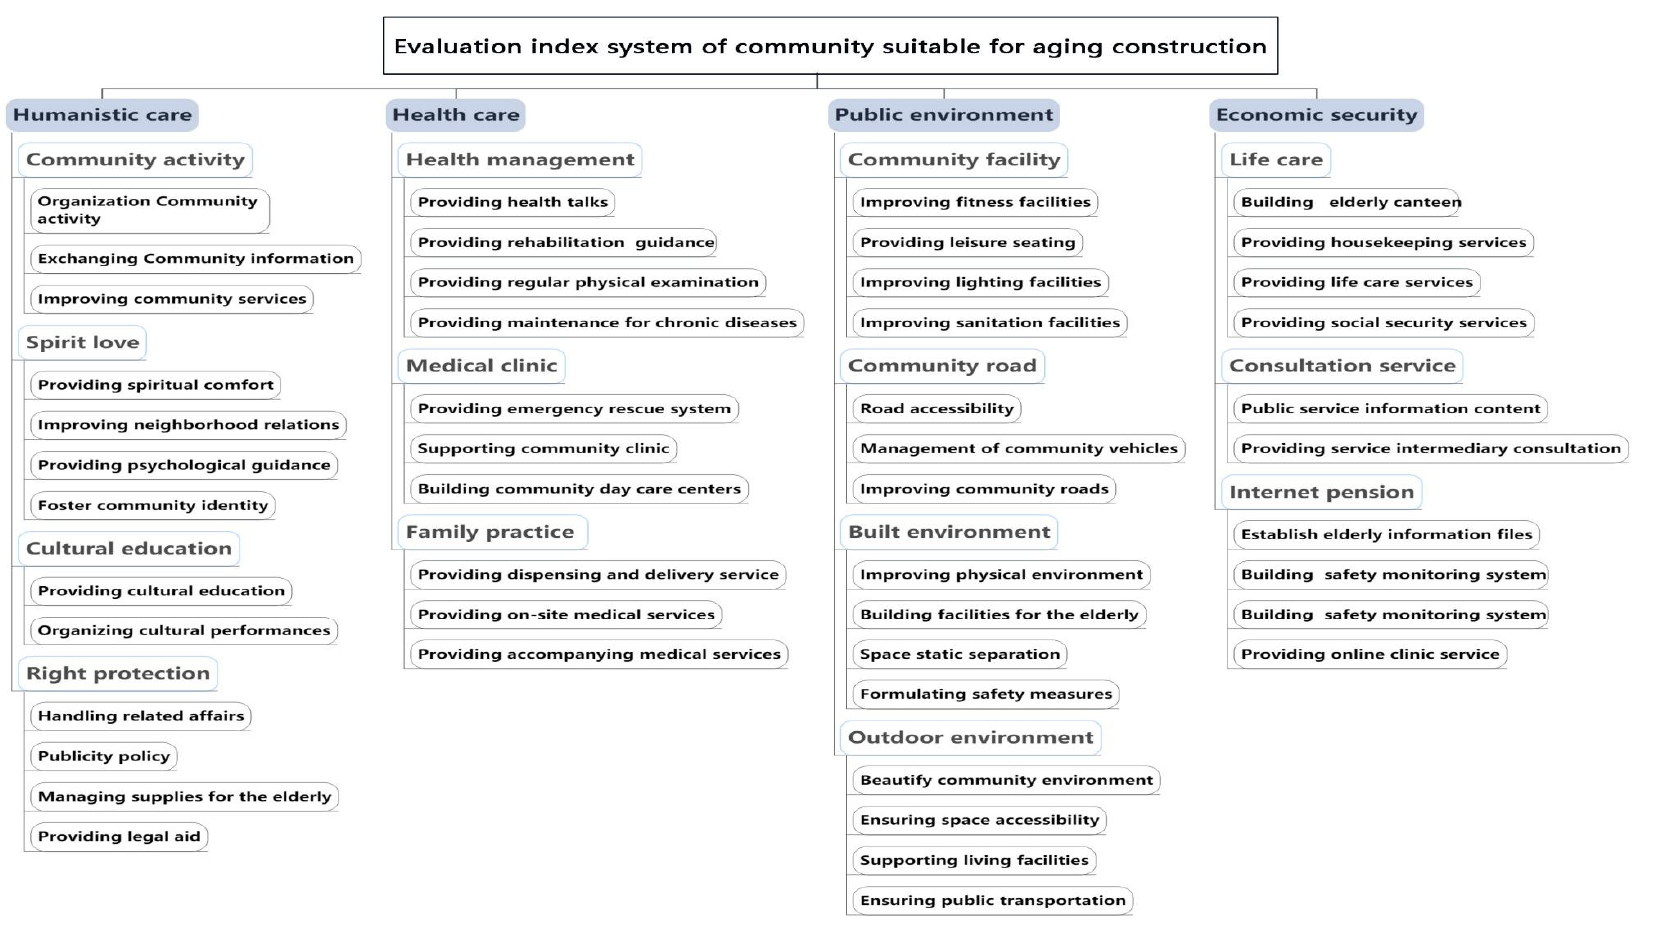
Figure 2. Evaluation index system of construction of communities suitable for aging.